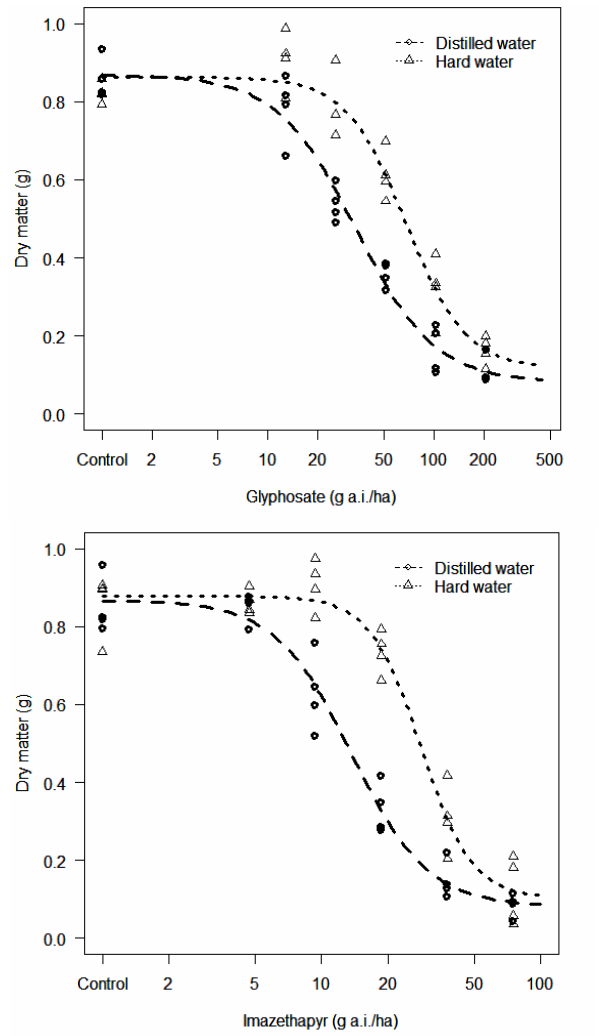
Fig. 2. Log-logistic dose-response for shoot dry weight of jimsonweed ( Datura stramonium L.) to imazethapyr or glyphosate when they were applied with the carriers of distilled water ( о ) and hard water ( ∆ ). The r 2 values for the regression model were 0.98 and 0.96 for distilled and hard water,